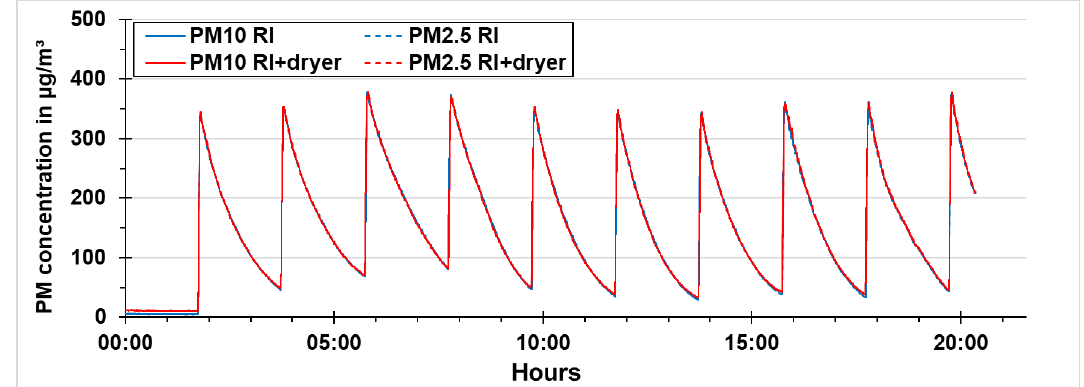
Figure 16. PM concentrations of the reference instruments during quality assurance.